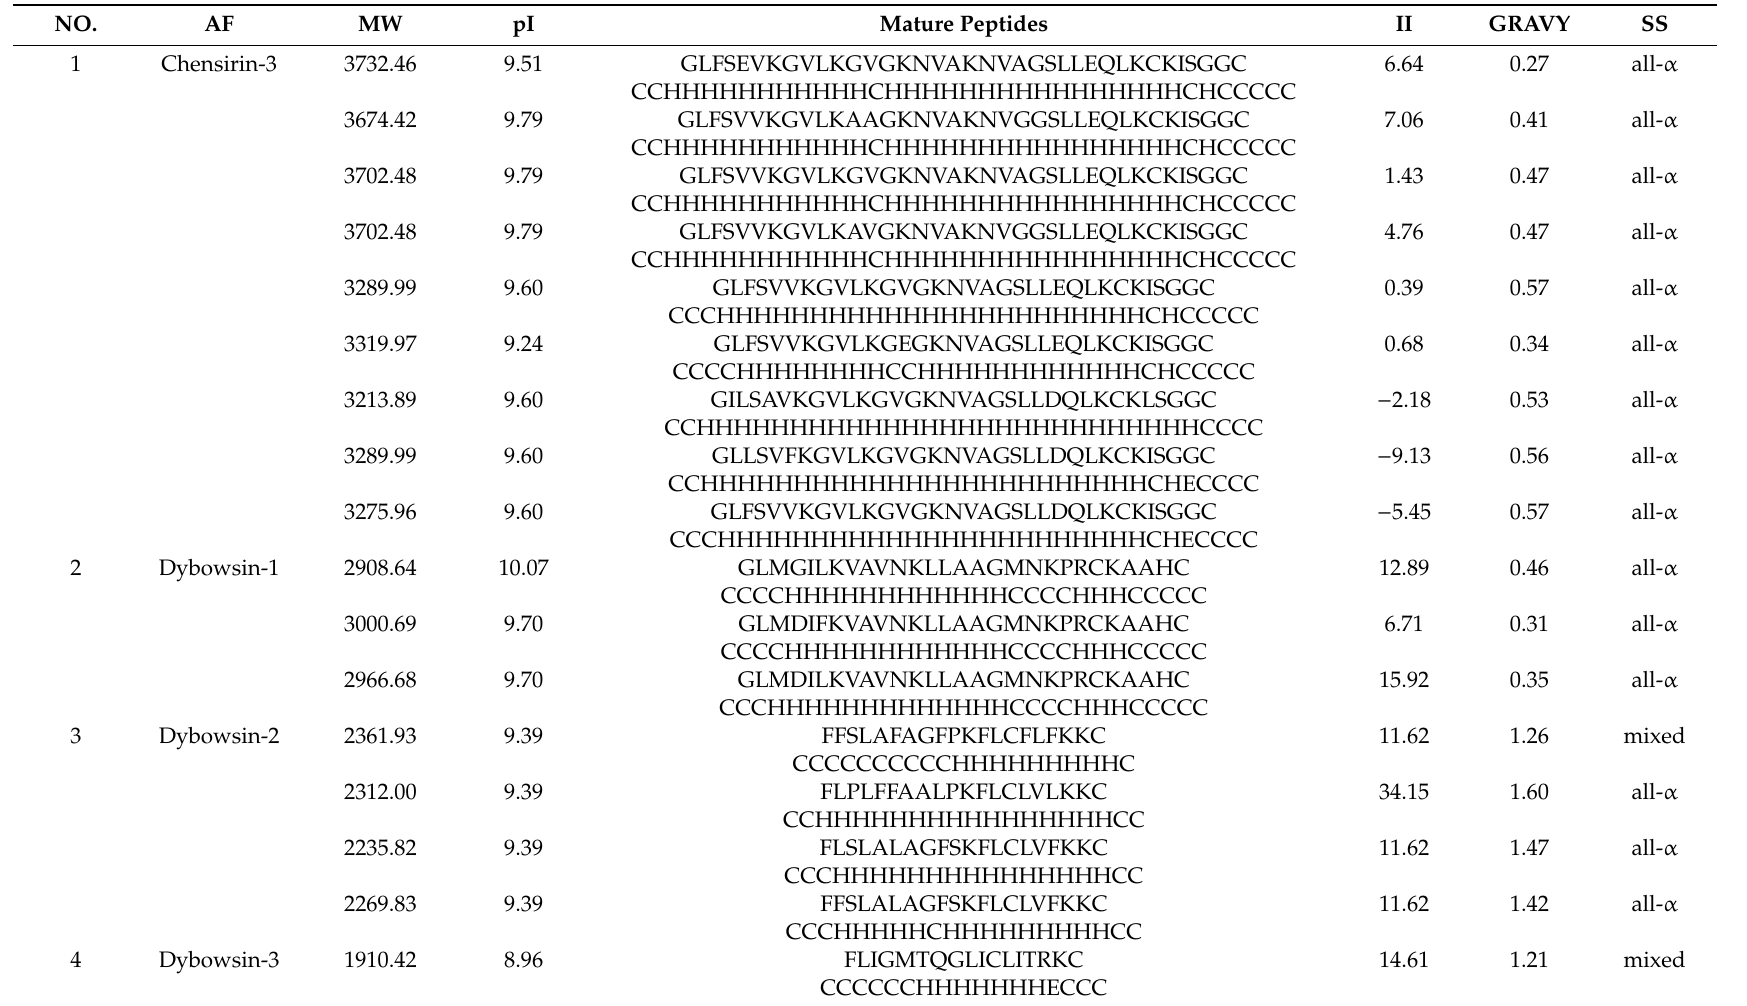
Table A2. The physicochemical and structural properties of mature peptides from R. dybowskii